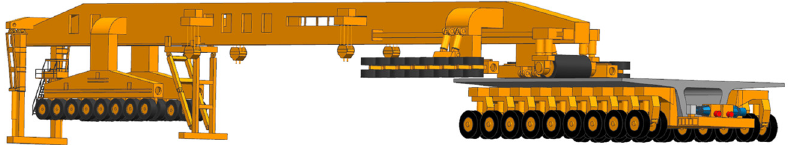
Figure 31. Summary solution two. Table 3. Design solution evaluations.